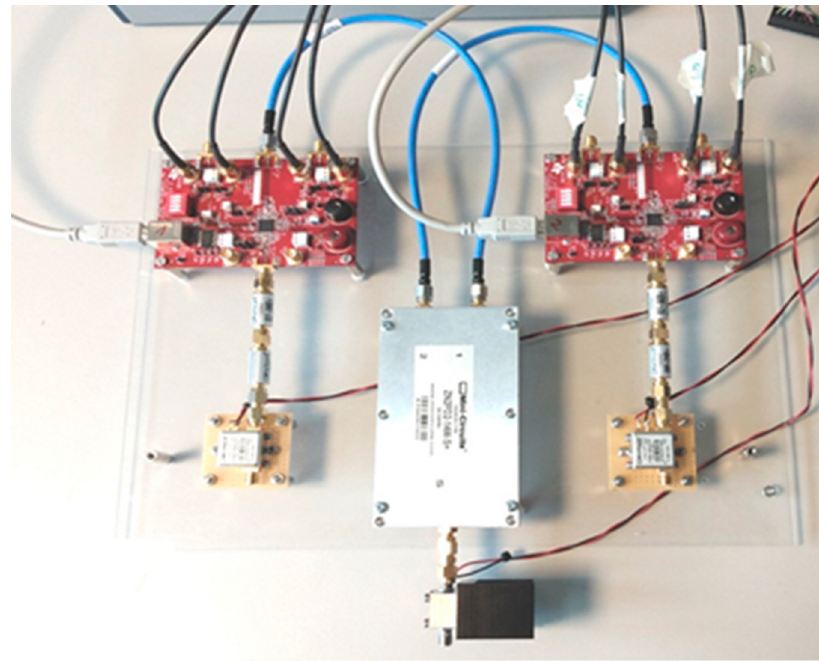
Figure 5. Electronic components with two separate receiver paths including I/Q demodulation on the right side and the left side. Receiver antennas are not connected to the low noise amplifier (LNA) at the bottom (left and right). In the middle, we used a splitter for a 500 to 10,500 MHz frequency range for the two receiving paths. Carrier signal is inserted at the bottom of the setup.